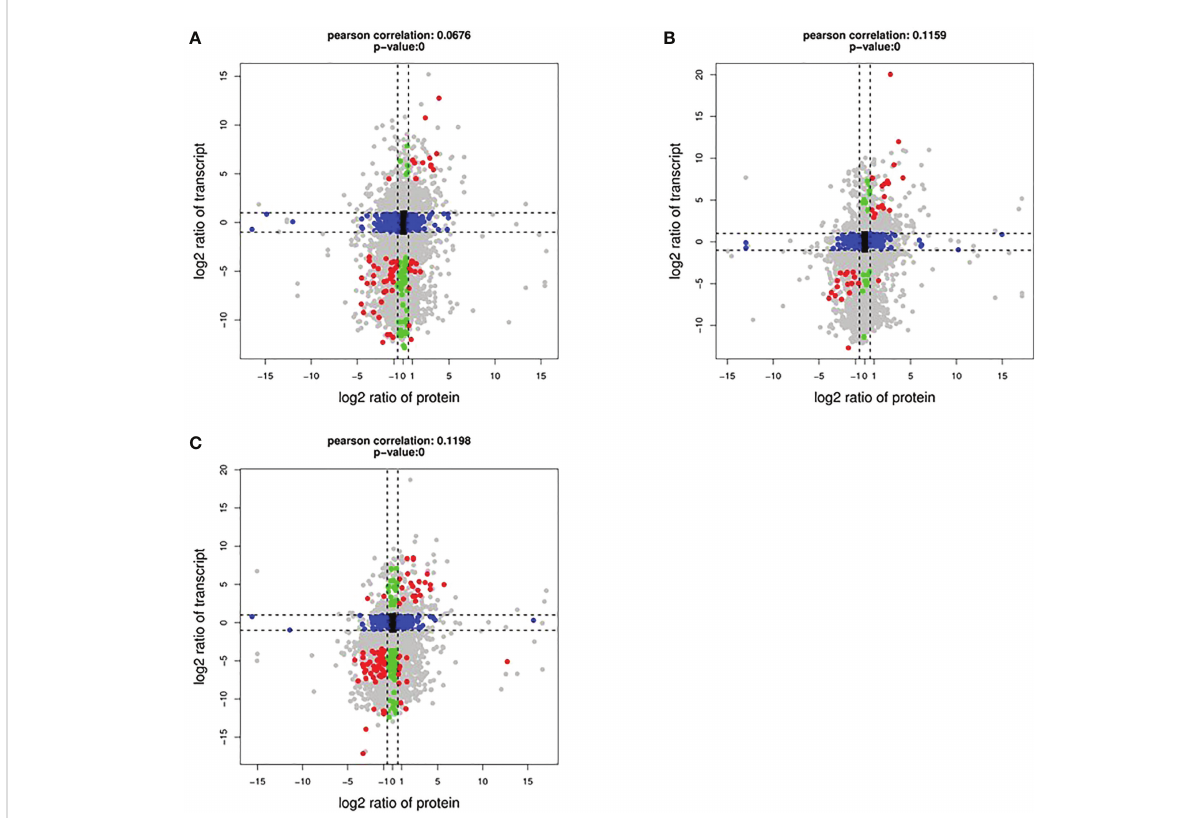
FIGURE 7 Log 2 expression ratios in the transcriptome (y-axis) and proteome (x-axis). HT (A) , DR (B) , and DH (C) conditions. Signi fi cant alterations in expression are indicated by color: blue, protein; green, transcripts; red,